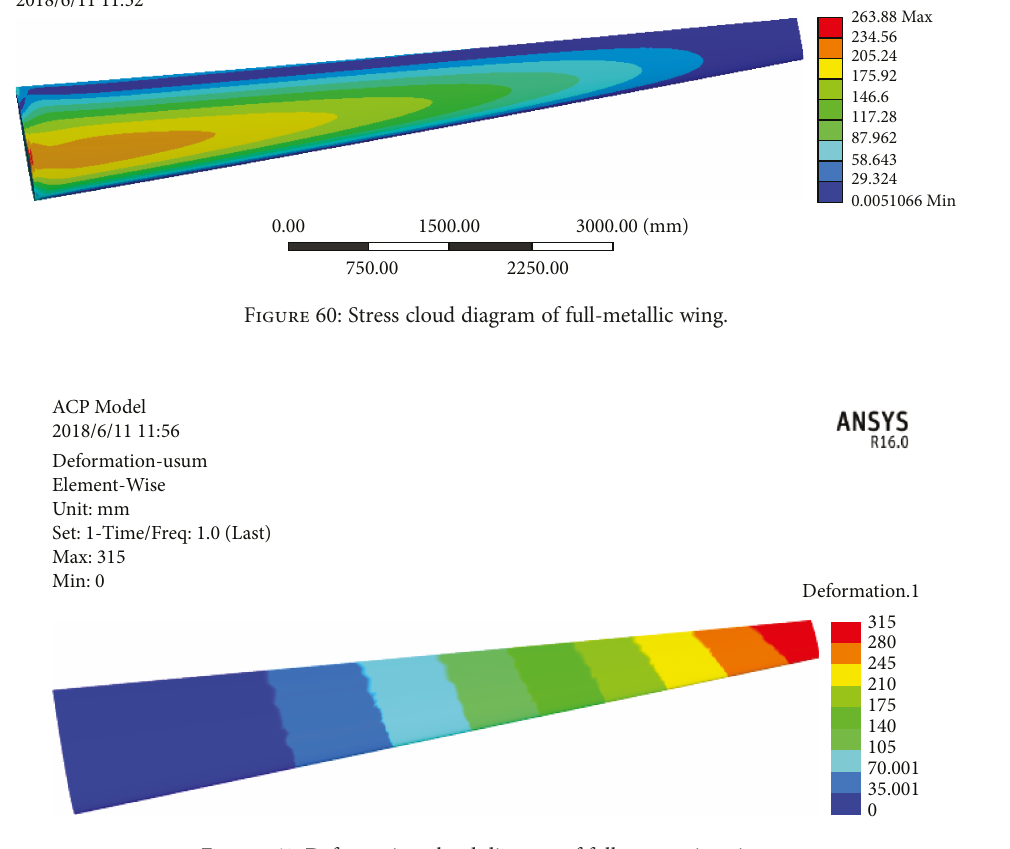
Figure 61: Deformation cloud diagram of full-composite